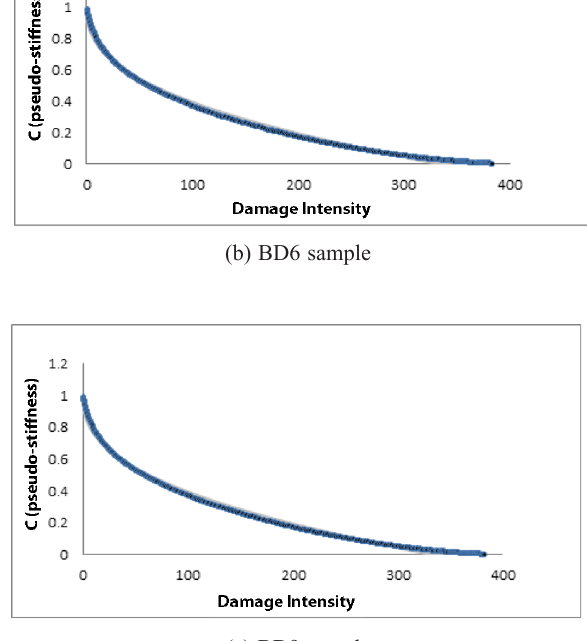
Table 4. Damage characteristics of binders after LAS testing